Question: Write a single sentence explaining what this figure depicts.
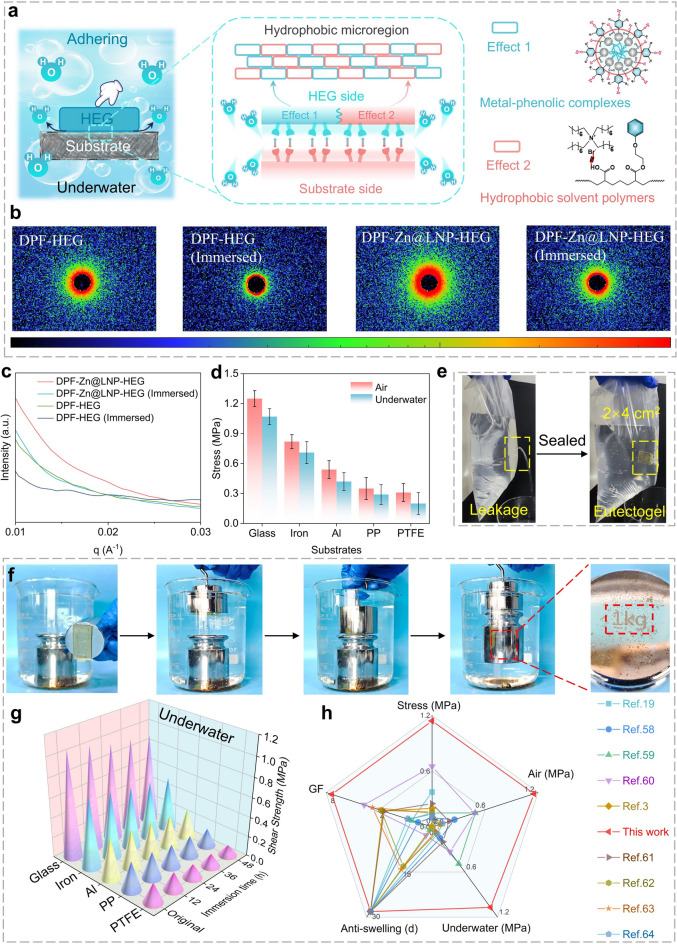
Answer: Adhesion performance of DPF-Zn@LNP-HEG. a Schematic diagram of self-hydrophobization process and hydrophobic microdomains. b 2D SAXS patterns and c SAXS spectra of DPF-HEG/DPF-Zn@LNP-HEG before and after immersed in water. d Comparison of adhesion strengths on different substrates in air and underwater. e Photo images of HEG for sealing material. f Instantaneous underwater adhesion on an iron substrate. g Evolution of shear strengths after immersion in seawater for different durations. h Radar chart comparing the HEG’s anti-swelling ability, tensile strength, air/underwater adhesion, and gauge factor with other reported eutectogels